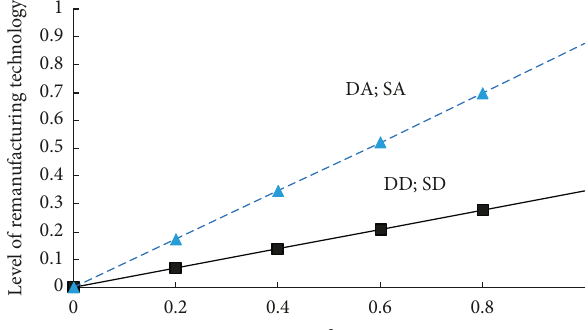
Figure 2: The linear relationship between ε and the remanufacturing technology level.